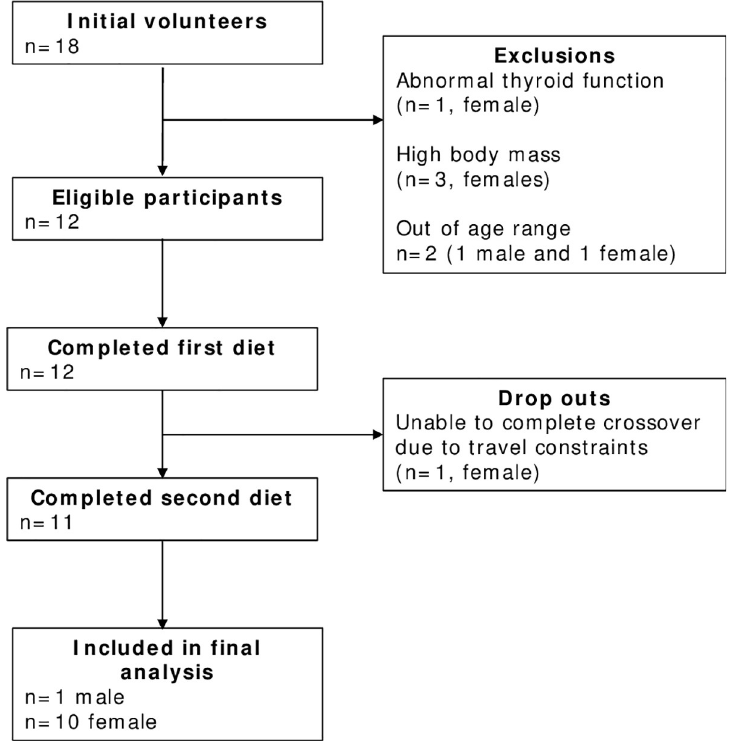
Fig 1. Flow of participants throughout the study from recruitment to inclusion in final analysis.